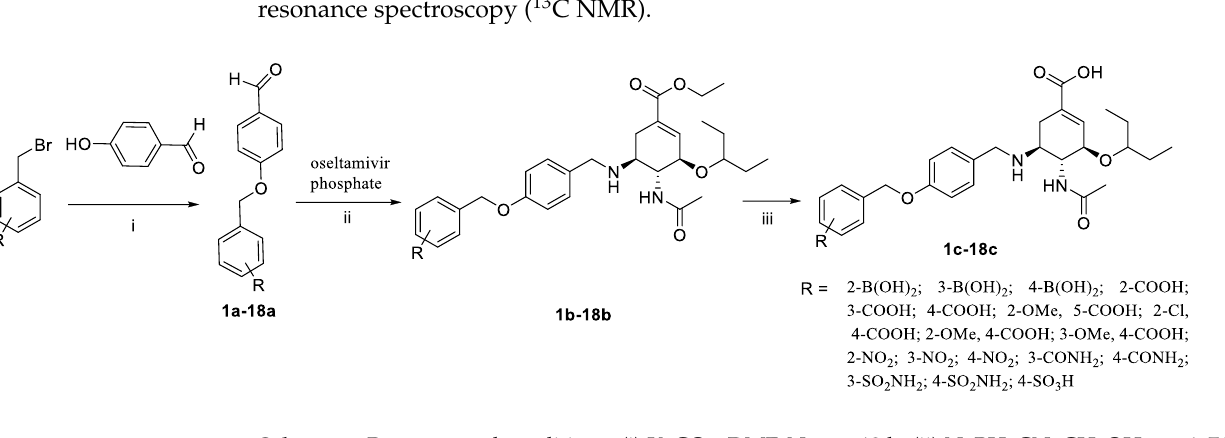
Figure 4. Further optimization of oseltamivir analogues EJMC5c and EJMC13c targeting 150-cavity via bioisosteric replacement strategy.